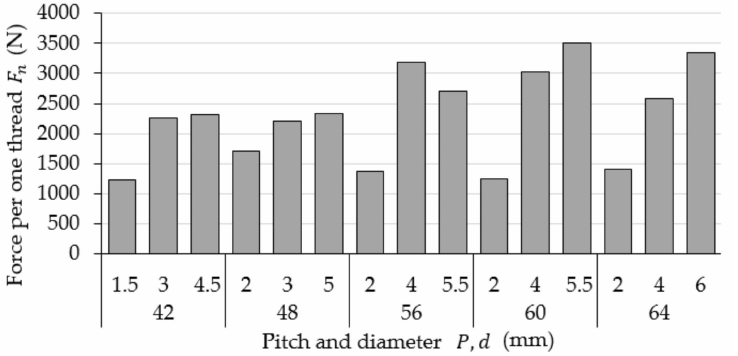
Figure 6. Calculated values of the force applied to one active thread ridge that cooperates with the nut F n .